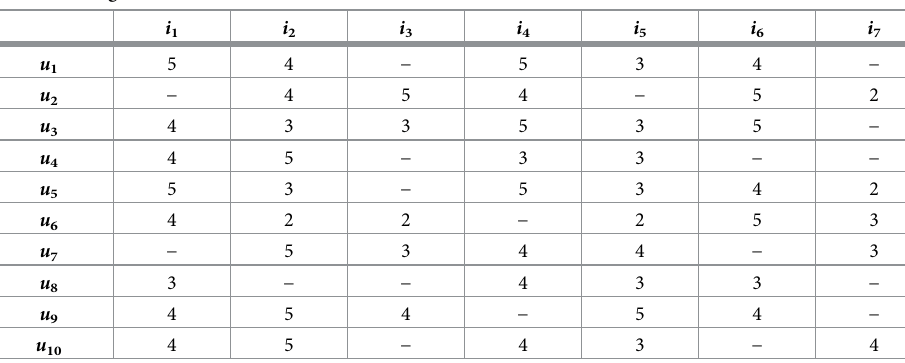
Table 3. Rating matrix.